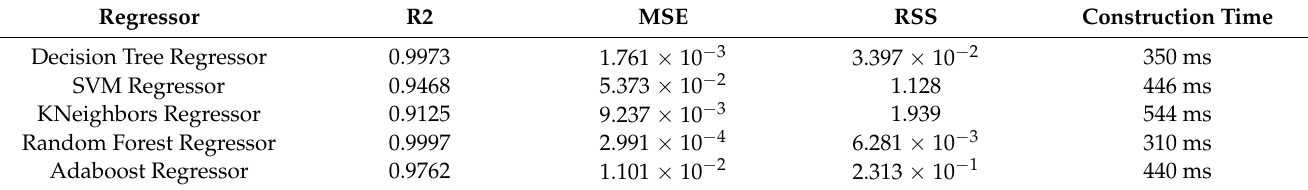
Table 3. Evaluation metrics of different regression models with the same amount of training